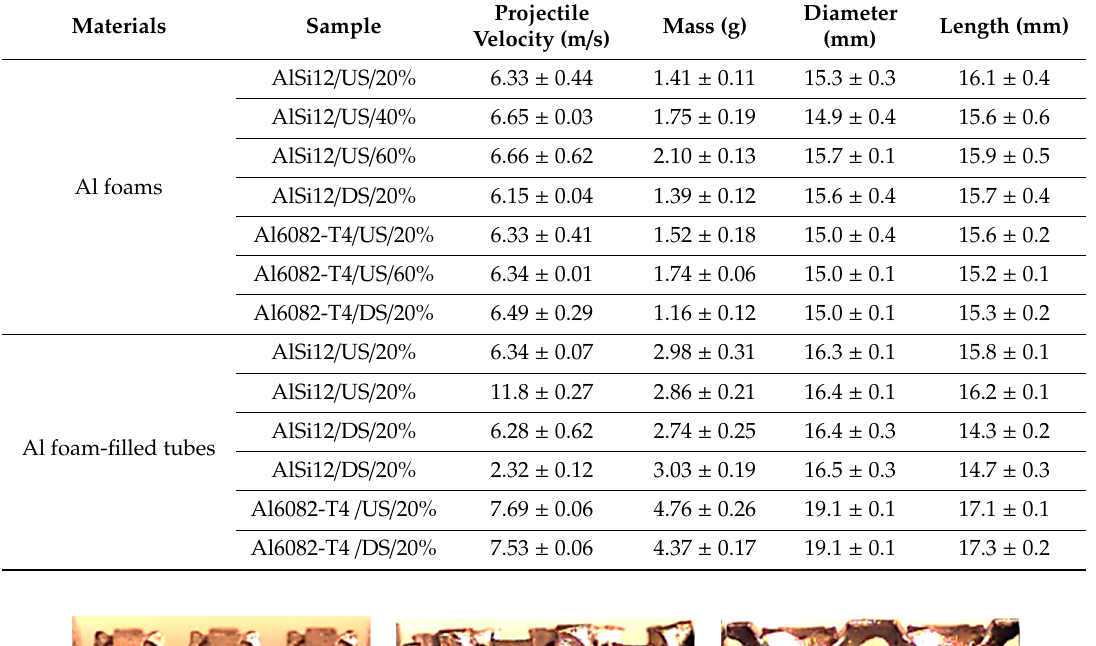
Table 3. Samples’ dimensions and experimental conditions for Al foams and foam-filled tubes.